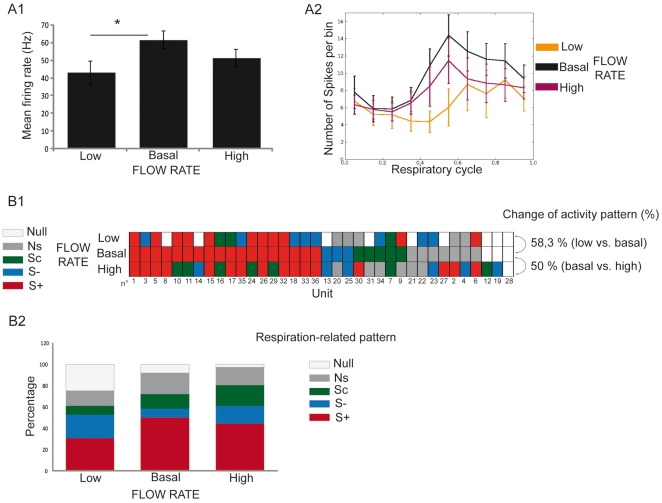
Nasal flow rate modifies mitral cell response to odors.Thirty six mitral cells were recorded under the three flow rate conditions. A1) Mean instantaneous frequency rate (± SEM) under each flow rate condition (n = 36). Paired t-test, *p<0.05. A2) Mean instantaneous frequency (or number of spikes per bin, ± SEM) as a function of respiratory cycle under the three flow rate conditions (low flow rate: orange, basal flow rate: black, and high flow rate: purple). B1) Matrix representing respiration-related patterns of each cell recorded under the three flow rate conditions. Each line represents a flow rate condition, and each column represents a unit. A color was attributed to each pattern: excitatory synchronized (S+, red), suppressive synchronized (S−, blue), complex synchronized (Sc, green), respiration non-related (NS, dark gray) and null activity (NULL, light gray). Cells are ordered according to their respiratory-related pattern at basal flow rate. The percent of change in activity pattern represents the percent of units exhibiting a different pattern under the two flow rate conditions. B2) Percentages of each activity pattern as a function of flow rate condition (n = 36). Low and high nasal flow rate conditions were compared to the basal flow rate. Statistical test: chi2.